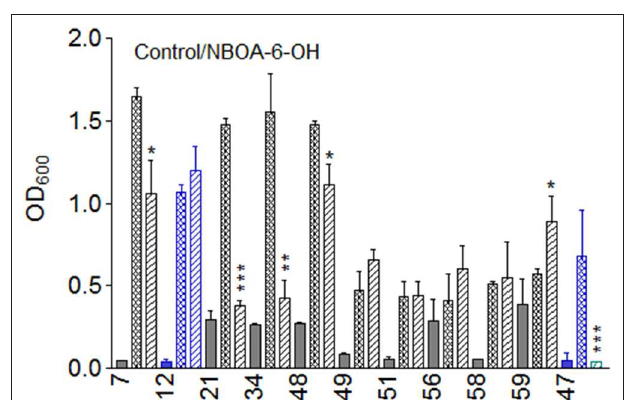
FIGURE 8 | Growth of the microorganisms in the presence of NBOA-6-OH. n = 5; * p < 0.05; ** p < 0.005; *** p < 0.0005). Nd, not detectable. Microorganisms: Mycobacterium fortuitum (7), Bacillus aryabhattai (34), Bacillus cereus (59), Bacillus megaterium (21, 48); Bacillus methylotrophicus (58), Lysinibacillus xylanilyticus (56), Paenibacillus polymyxa (51), Aminobacter aminovorans (49), the fungi Papulaspora sepedonioides (12), and Trichoderma viride (47) . Blue bars, fungi; gray bars, bacteria. OD 600 culture start, ; OD 600 after 72 h: control, ; OD 600 in presence of 17 .